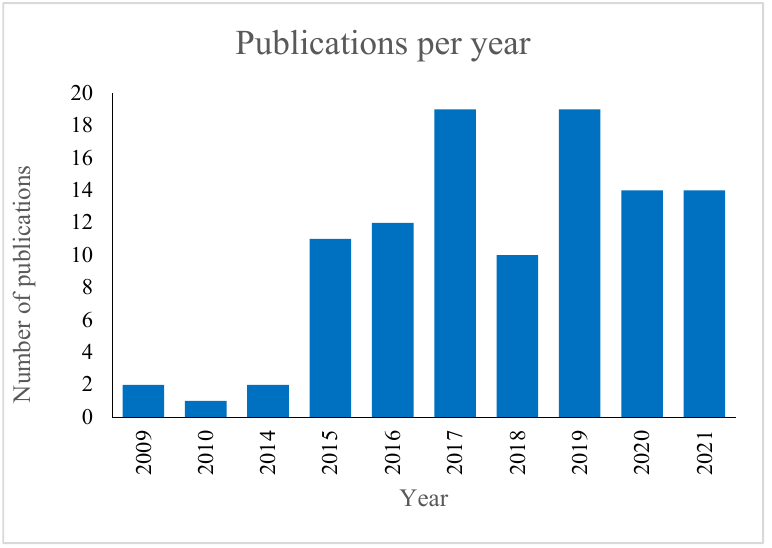
Figure 2. Number of publications per year. Own elaboration from SCOPUS data.